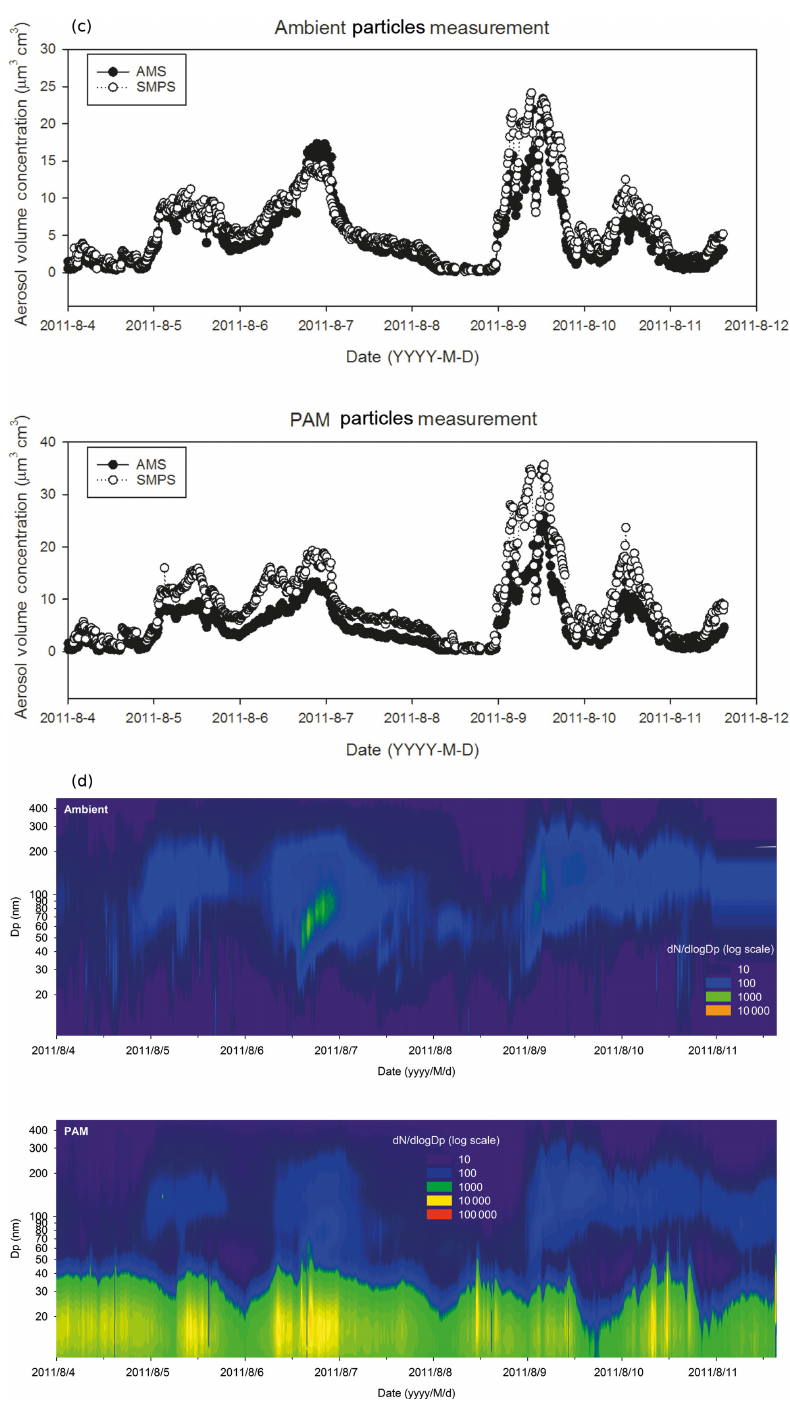
Figure 2. (a) Aerosol particle mass concentrations from SMPS measurements for ambient and PAM aerosols. (b) Mass concentrations of major components measured by HR-ToF-AMS including organics, nitrate, sulfate, ammonium, chloride, and m/z 43 and m/z 44. Solid lines and lines with markers represent ambient aerosol particles and PAM aerosol particles, respectively. Shaded periods represent the organics- dominated episode (6 August 11:00LT to 7 August 09:00LT) and the sulfate-dominated episode (9 August 01:00LT to 9 August 14:00LT). The lowest mass concentration observed on 8 August was due to rain. (c) Time series of particle volume concentration measured from AMS and SMPS. Particle volume concentration from AMS was calculated with mass concentration and composition-dependent density. (d) The size-separated number concentrations of ambient and PAM aerosol particles measured by